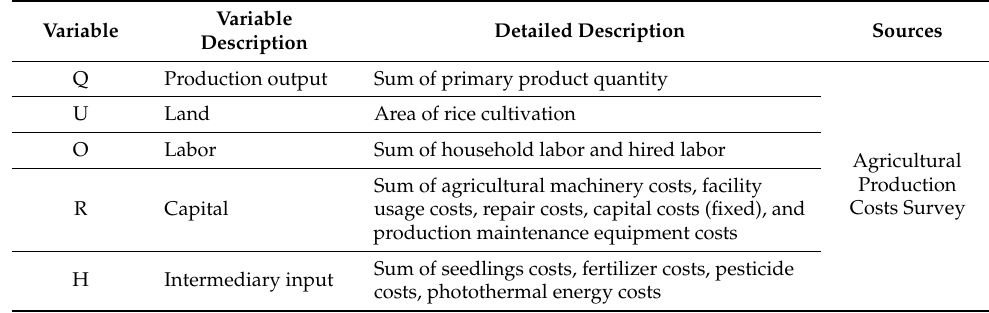
Table 3. Description of variables used in productivity